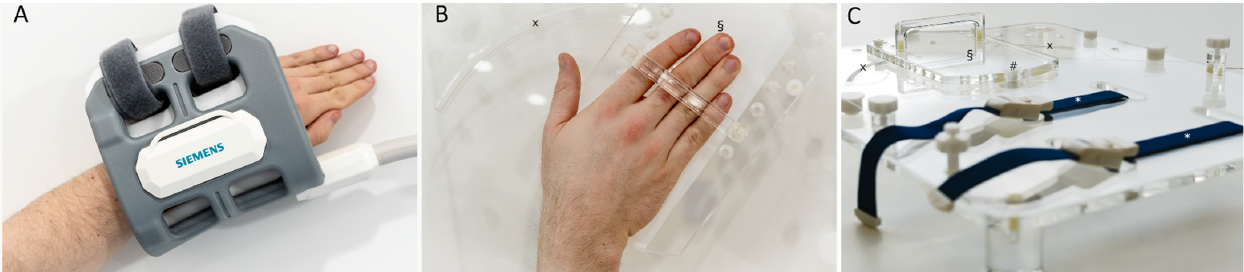
Figure 1. Coil and measurement setups during static reference and dynamic real-time MRI measurements. ( A ) For static measurements, a four-channel flex coil (Siemens Healthineers) was wrapped around the wrist to acquire the morphologic sequences. Shown are a left forearm and hand that were immobilized and imaged for reference purposes. ( B ) Positioning of a right wrist on the custom-made MRI-compatible movement device. The device has a mobile sliding tray (§) with a predefined range and trajectory of movement (x) onto which the hand was placed. ( C ) Tourniquets (*) were used to fix the forearm and prevent adaptive movement. The underside of the mobile sliding tray was coated with synthetic polytetrafluoroethylene (“Teflon”) to reduce friction. Centered underneath the wrist is the pivot point (#), which connects the mobile sliding tray and the fixed base plate. For dynamic measurements, a 24-channel spine matrix coil and an 18-channel body coil (both from Siemens Healthineers) were positioned underneath (spine matrix coil) and on top of the device (body coil) [not